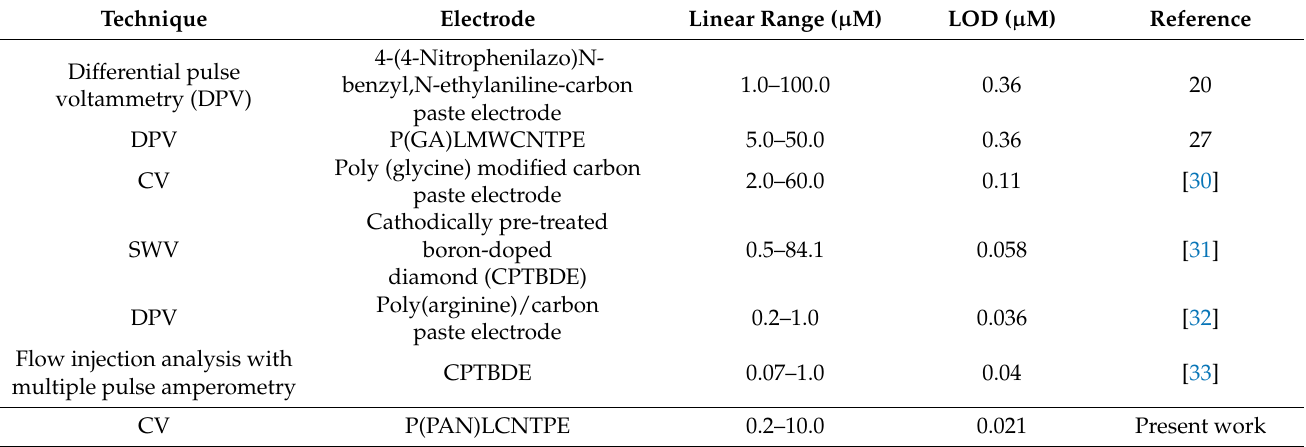
Figure 9. ( a ) Cyclic voltammograms for ICN with different concentration ranging from 0.2 µ M to 10.0 µ M in PB (0.2 M & 6.5 pH) at the surface of P(PAN)LCNTPE having 0.1 Vs − 1 scan rate. ( b ) Plot of [ICN] vs. I pa . Table 2. Comparison of present LOD of ICN, electrode material, and methods used in previous ICN reports.